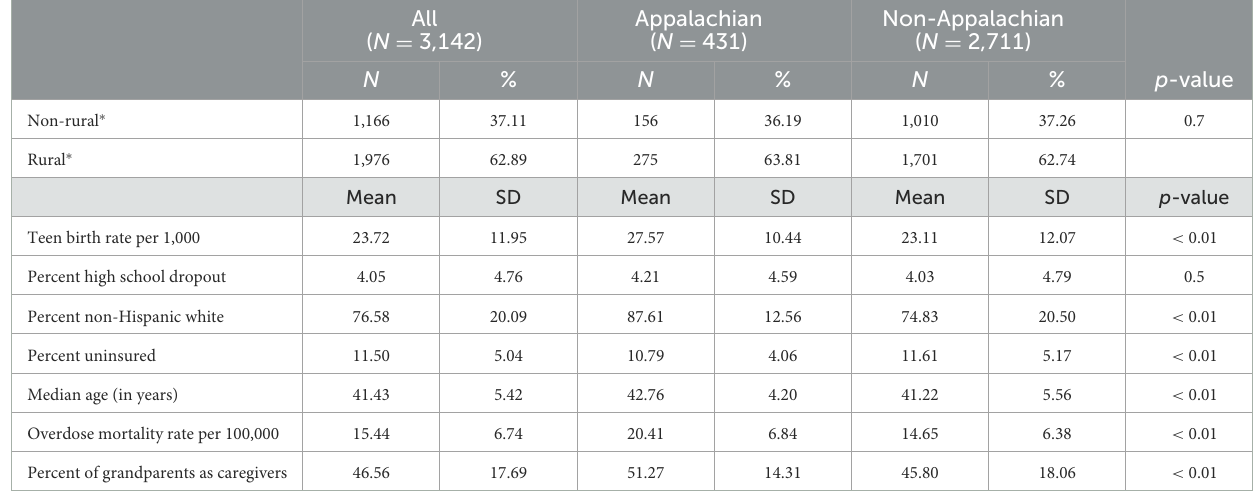
TABLE 1 Sociodemographic characteristics of U.S. counties, overall and by Appalachian